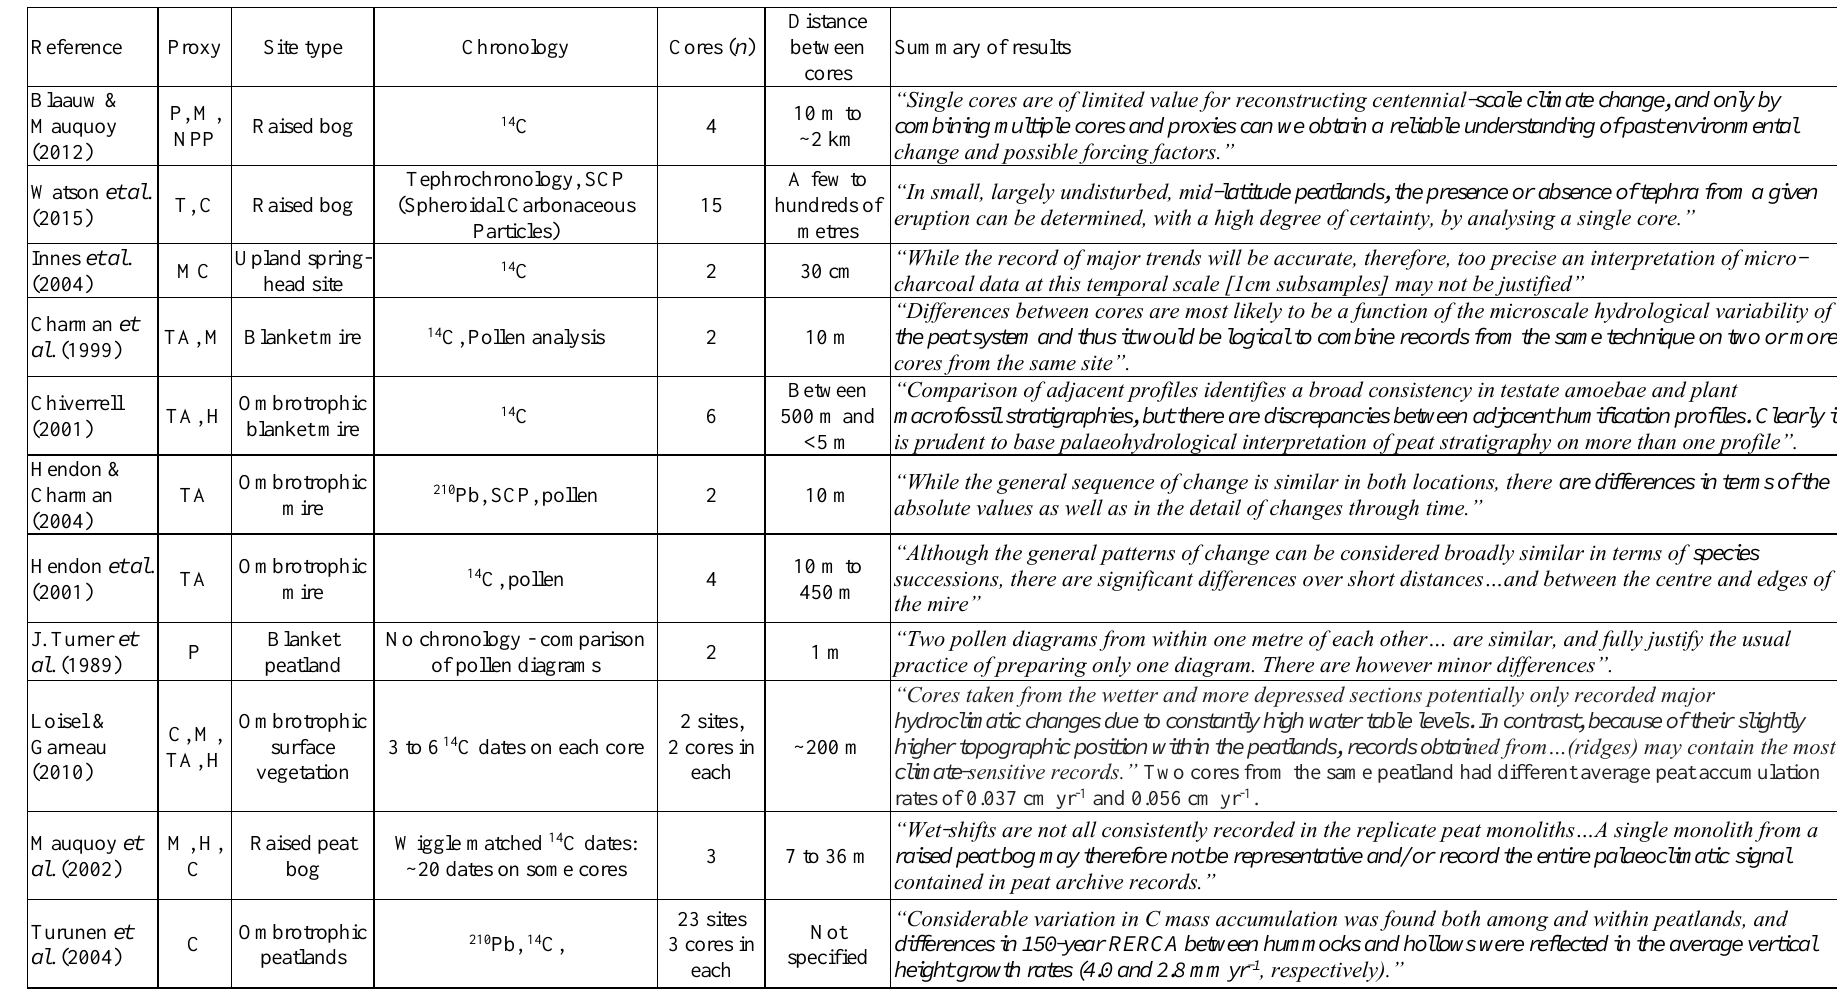
Table 1. Selected paleoenvironmental or carbon accumulation studies which include more than one core from a peatland. Only studies with an independent chronology have been included. Proxy abbreviations are as follows: P = pollen; M = plant macrofossils; NPP = non-pollen palynomorphs; T = tephra; C = carbon accumulation; MC = micro-charcoal; TA = Testate amoebae; H = humification. Other abbreviations: RERCA = average recent rate of carbon